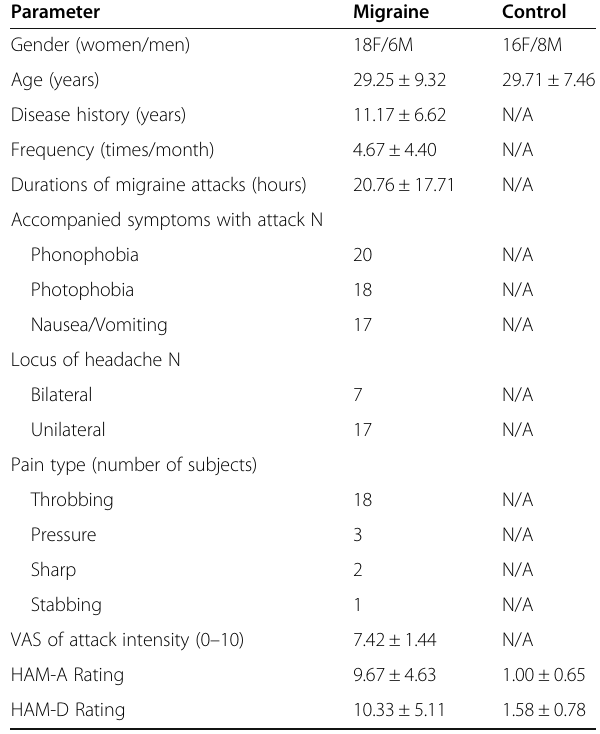
Table 1 Clinical features and neuropsychological evaluation